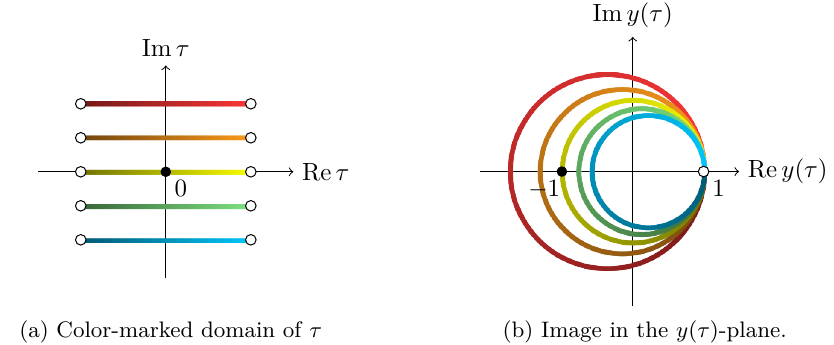
Figure 1 . Illustration of the variable transform τ 7→ y ( τ ) , with τ in units of 1 /ω 0 . Hollow small circles are understood to represent points at Re τ → ±∞ . The small circles and colored lines correspond to each other in the left and right